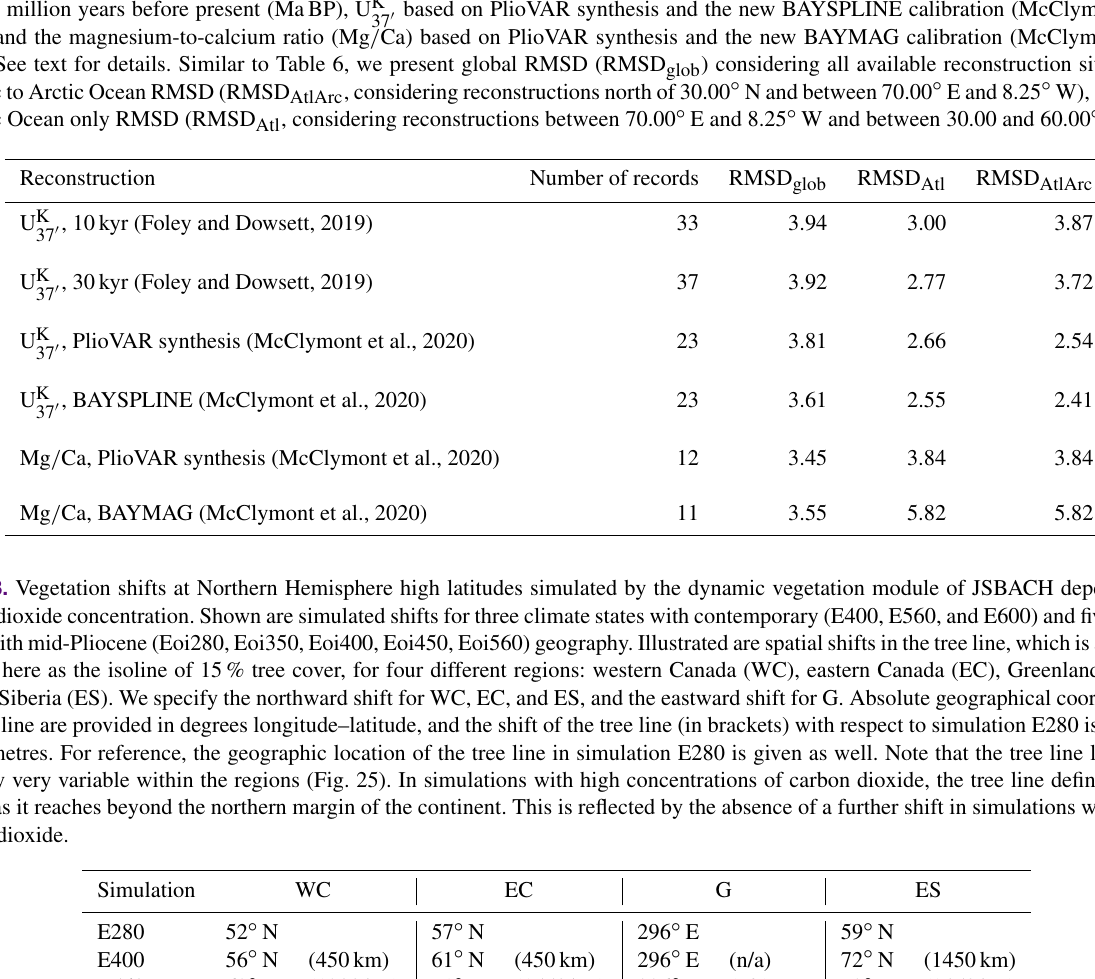
Table 7. Root mean square deviation (RMSD) between simulated and various reconstructed sea surface temperature data sets. Considered are alkenone-based (U K ) reconstructions by Foley and Dowsett (2019) referring to time windows of 3 . 205 ± 0 . 005 (10kyr) and 3 . 205 ± 0 . 015 37 (cid:48) (30kyr) million years before present (MaBP), U K based on PlioVAR synthesis and the new BAYSPLINE calibration (McClymont et al., 37 (cid:48) 2020), and the magnesium-to-calcium ratio (Mg / Ca) based on PlioVAR synthesis and the new BAYMAG calibration (McClymont et al., 2020). See text for details. Similar to Table 6, we present global RMSD (RMSD glob ) considering all available reconstruction sites, North Atlantic to Arctic Ocean RMSD (RMSD AtlArc , considering reconstructions north of 30.00 ◦ N and between 70.00 ◦ E and 8.25 ◦ W), and North Atlantic Ocean only RMSD (RMSD Atl , considering reconstructions between 70.00 ◦ E and 8.25 ◦ W and between 30.00 and 60.00 ◦ N).